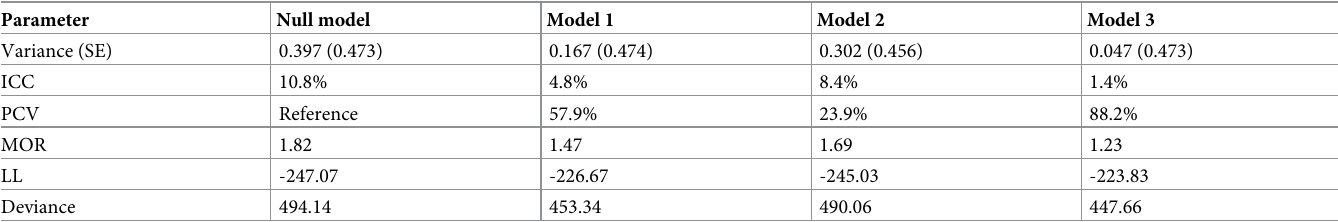
Table 3. Variability (random effect analysis) of uptake of MCV2 in